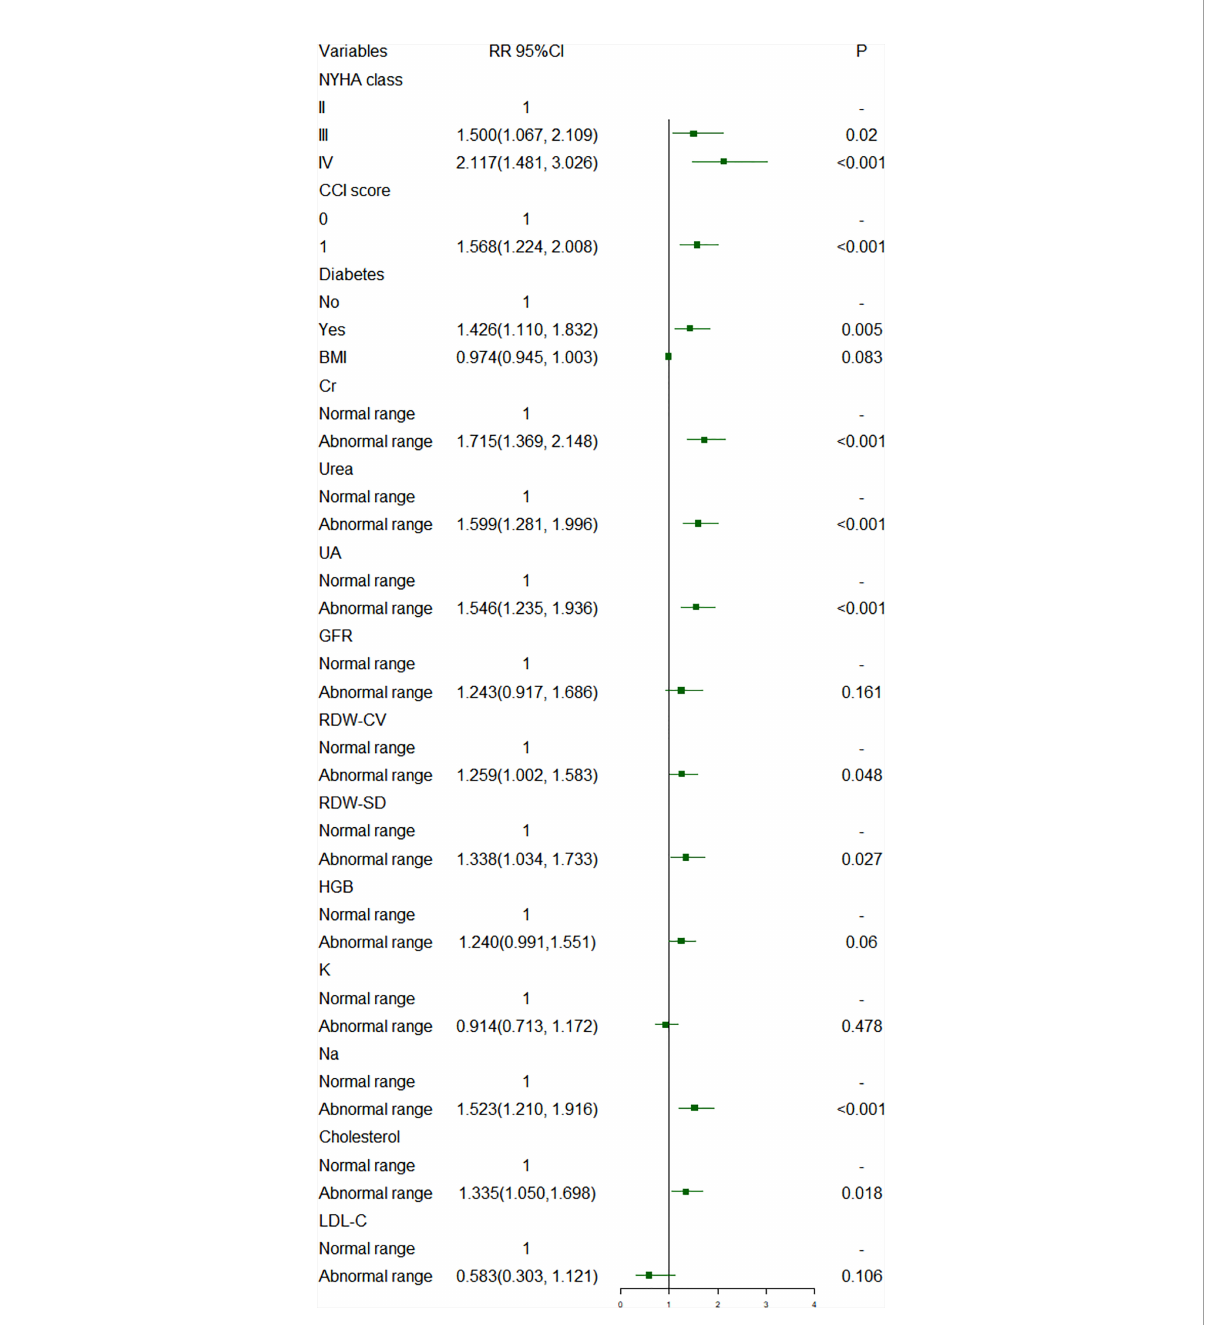
FIGURE 2 Risk factors for readmission within 3 months of heart failure patients: univariate logistic